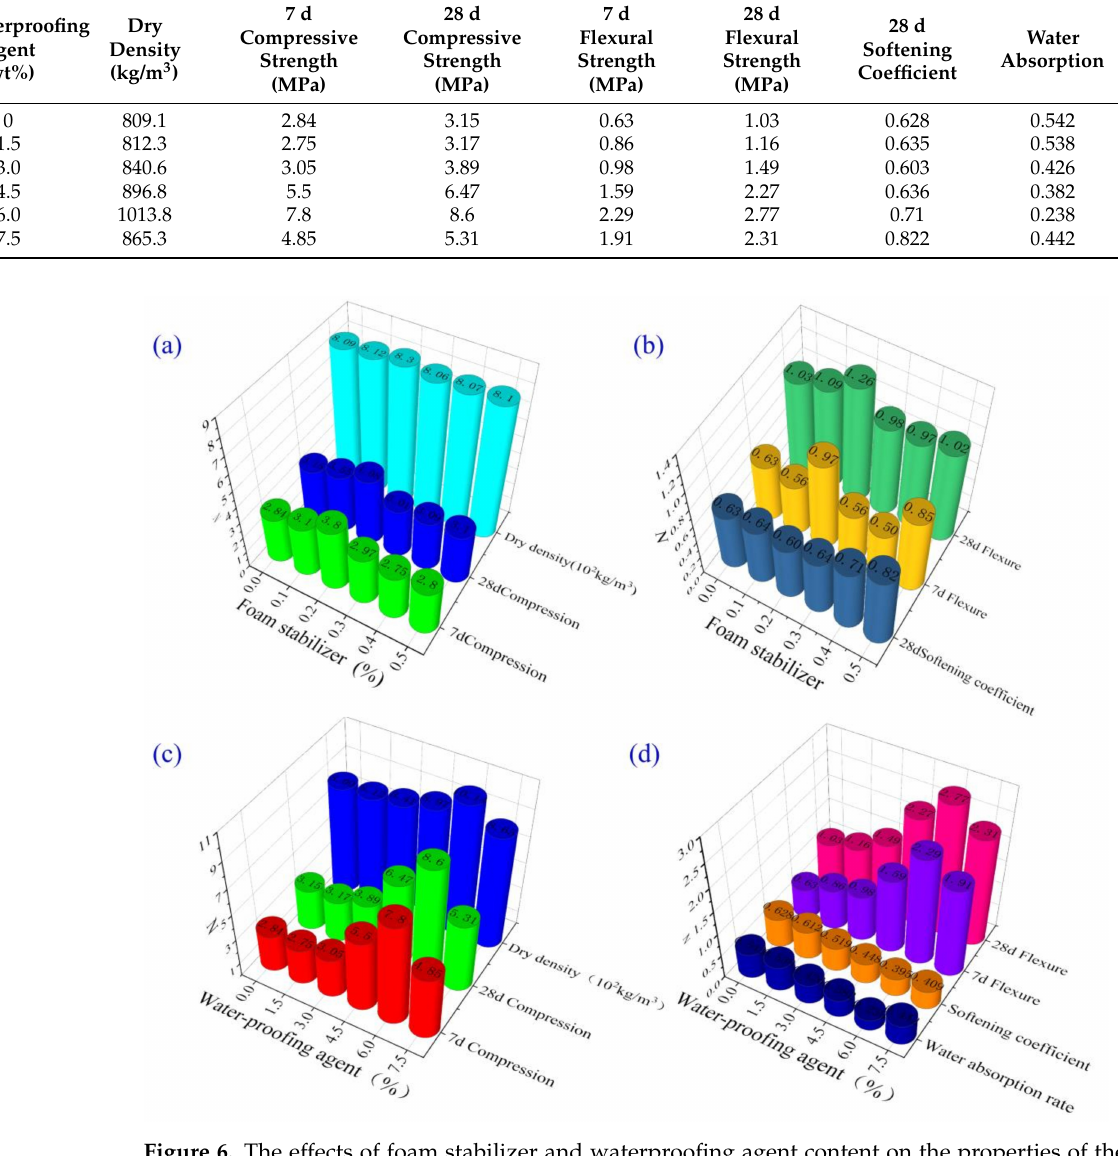
Figure 6. The effects of foam stabilizer and waterproofing agent content on the properties of the LFPM. ( a , b ) Effects of the foam stabilizer, ( c , d ) Effects of the water-proofing